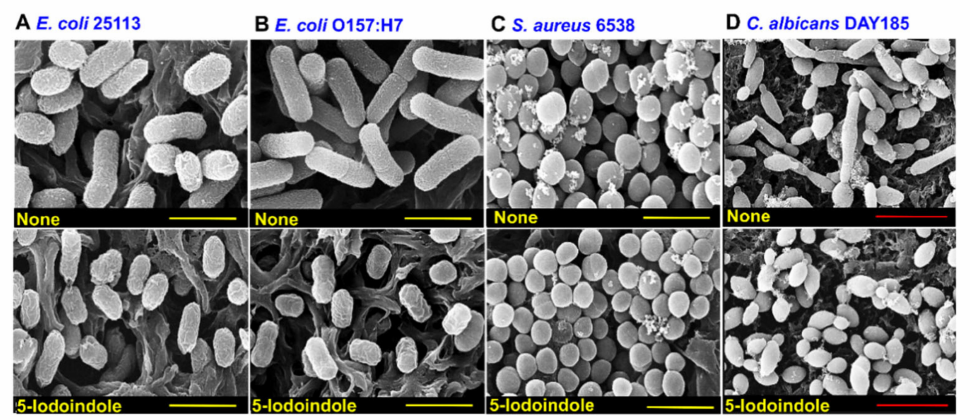
Figure 8. Morphological change by 5-iodoinole in other microbial cells. ( A ) E. coli BW25113; ( B ) E. coli O157:H7; ( C ) S. aureus ATCC 6538; ( D ) C. albicans DAY185 cells were grown with or without 5-iodoindole at 484 µ g / mL for 2 h and then fixed on nylon membrane filters. Scale bars: yellow = 1 µ m, red = 10 µ